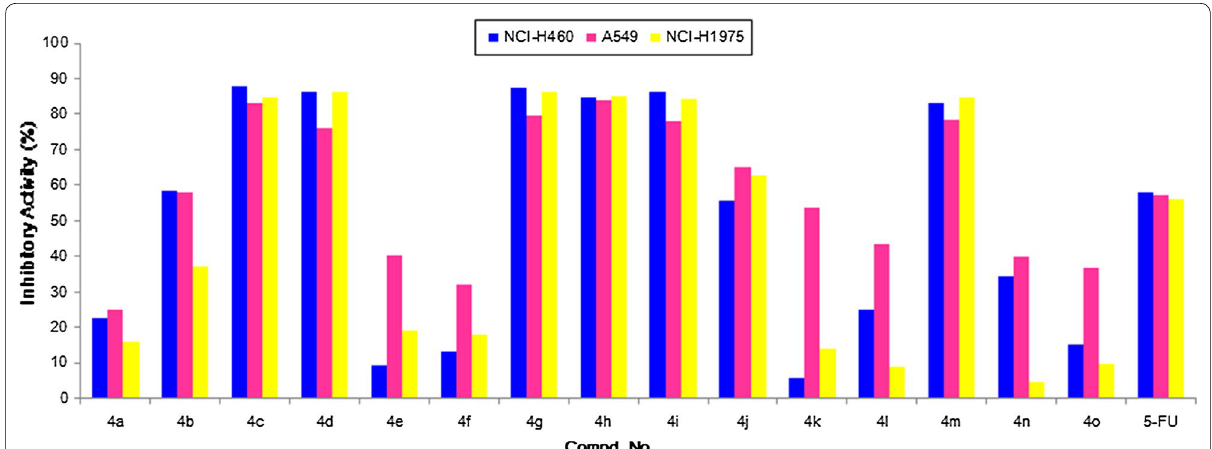
Fig. 4 Cytotoxic activities of compounds 4a–k and 4l–o at 40 µg/mL. NCI-H460 human large cell lung cancer cell line, A549 human lung cancer cell line, NCI-H1975 human lung cancer cell line, 5-FU 5-fluorouracil, used as a positive